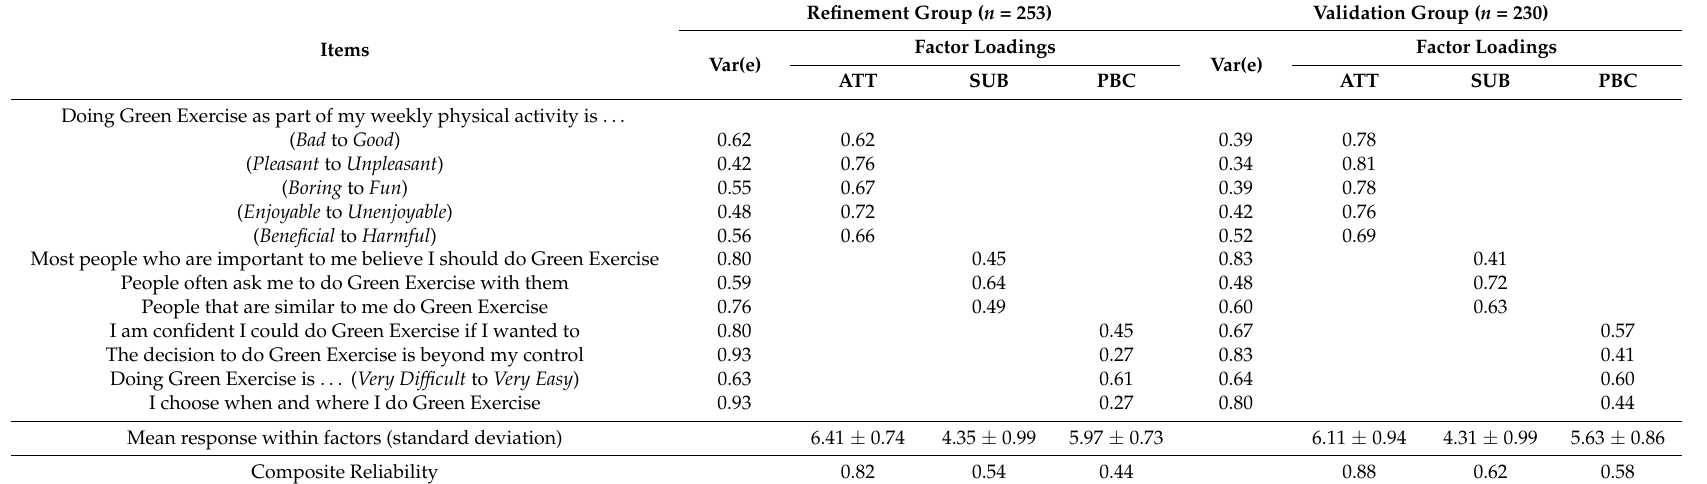
Mean response within factors (standard